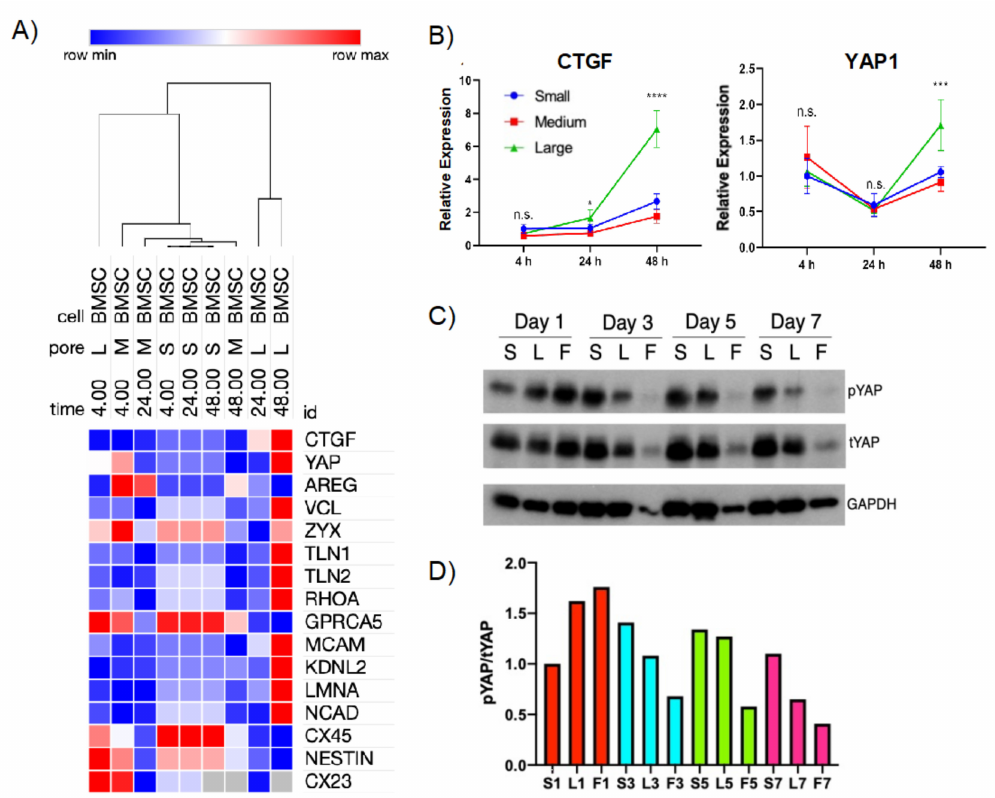
Figure 6. Gene expression analysis of cell–scaffold constructs demonstrate upregulation of mechanosensation and mechanotransduction related genes by 48 h in vitro ( A ). CTGF and YAP expression increase significantly in large pore constructs at 48 h ( B ). Western blot for YAP phospho- rylation (top, ( C )) and total YAP (middle, ( C )), compared to GAPDH (bottom, ( C )) from cell lysate of cells cultured on scaffolds for up to 1 week corroborate to suggest differential YAP regulation (S: small pore, L: large pore, F: flat/2D monolayer control; red = day 1, blue = day 3, green = day 5, pink = day 7), quantified in ( D ). * = p < 0.05, *** = p < 0.001, **** = p < 0.0001. n.s. =